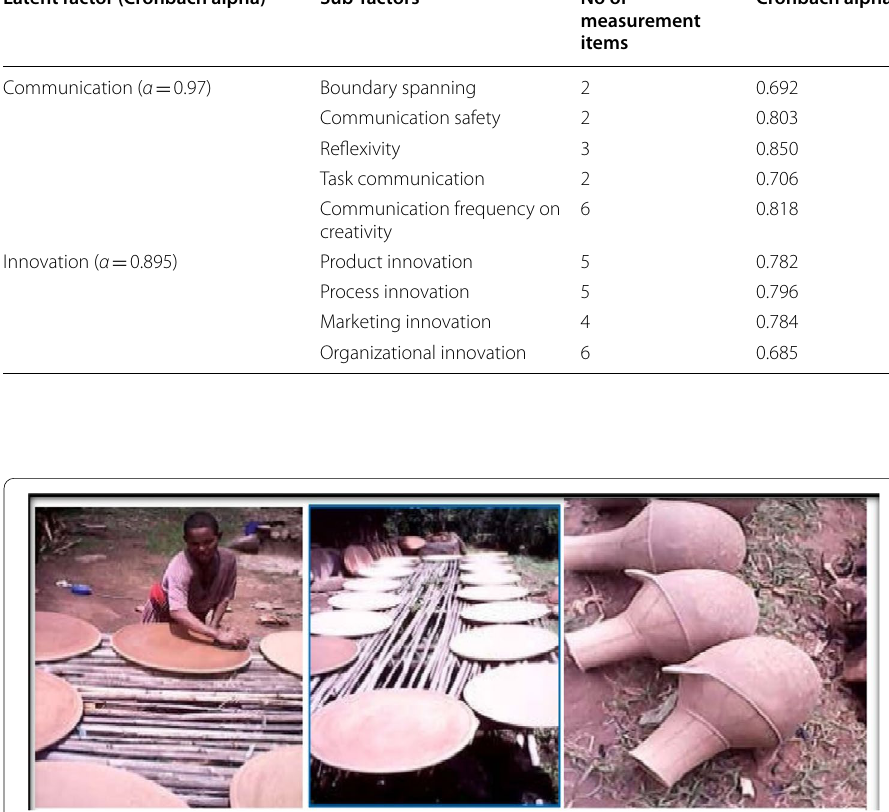
Table 1 Reliability of communication and innovation attributes as per research instrument Latent factor (Cronbach alpha) Sub-factors No of Communication ( α 0.97) =